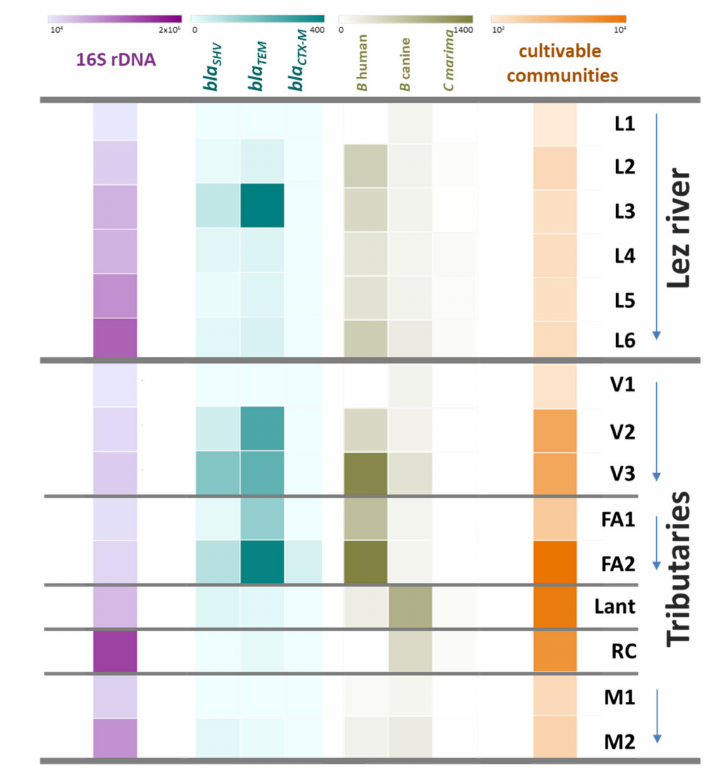
Figure 5. Absolute abundances of total 16S rDNA, of β -lactamase encoding genes ( bla TEM , bla SHV , and bla CTX-M ) and of host-associated molecular fecal markers (human and canine-specific Bacteroides and gull-specific C. marimammalium ) during the C2 campaign. Results are expressed in copy num- ber/mL. Cultivable community abundances, expressed in CFU/mL, are included for comparison. L1 to L6: Lez River; V1 to V3: Verdanson River; FA1 and FA2: Font d’Aurelle River; Lant: Lan- tissargues River; RC: Rieu Coulon River; M1 and M2: Mosson River. Arrows represent water flow